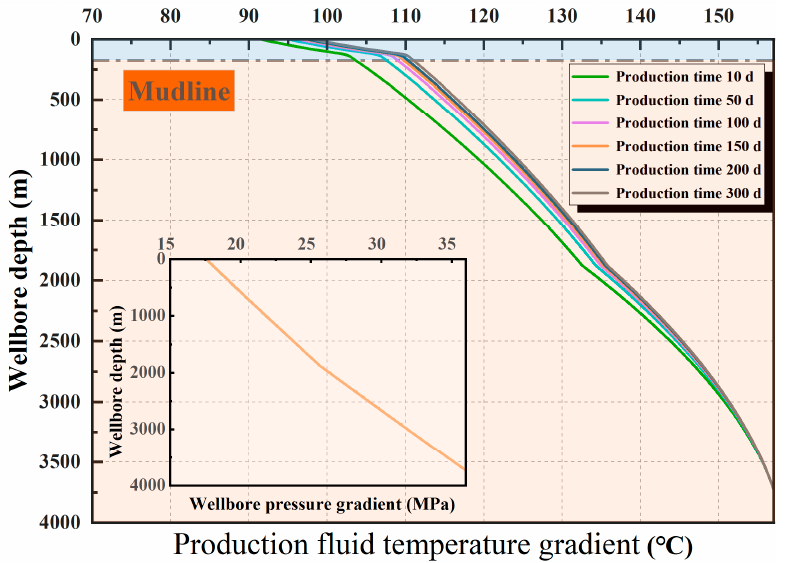
Figure 11. The influence of production time on wellbore temperature and pressure.